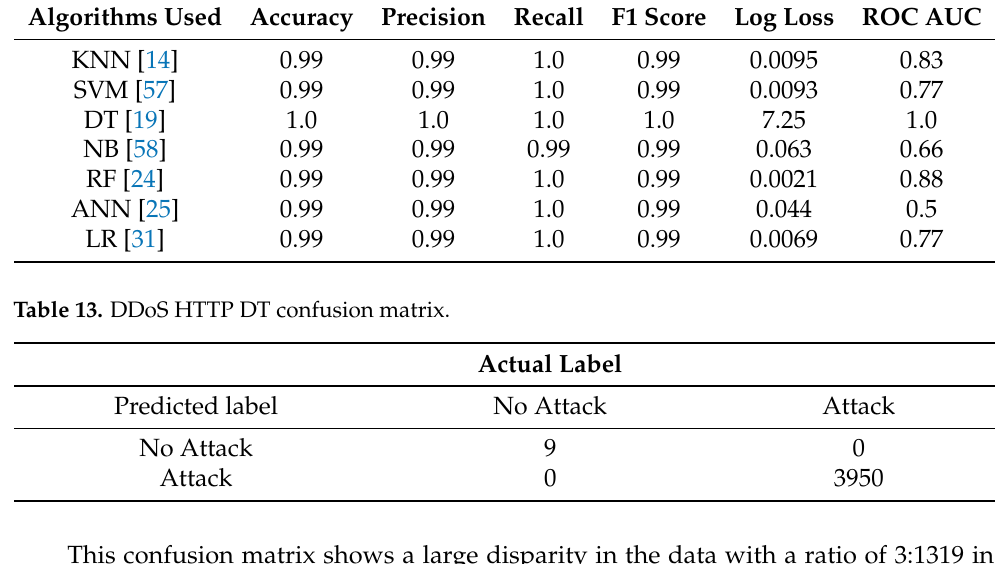
Table 12. DDoS HTTP results.